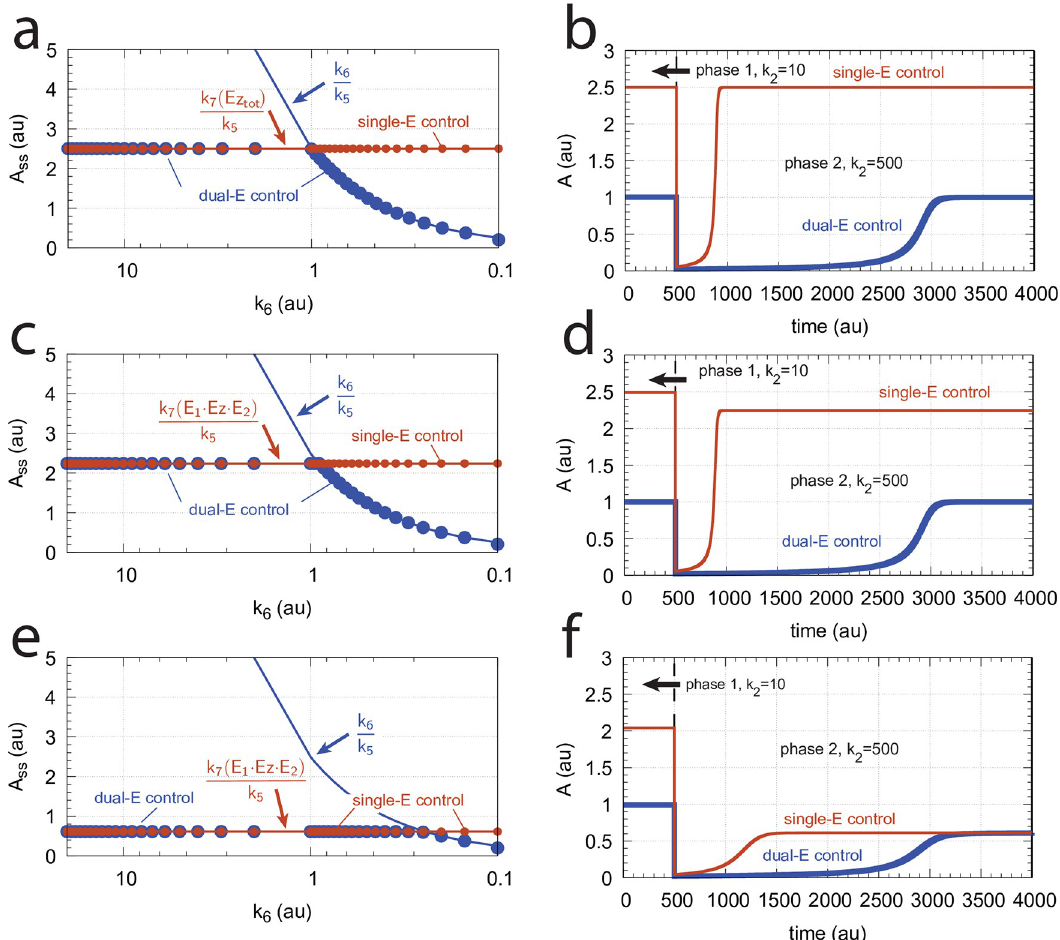
Fig 10. Behaviors of single-E control and dual-E control for the schemes in Fig 9e and 9f when going from zero-order to nonzero-order conditions. In panels (a) and (b), k 9 = k 11 = k 13 = k 15 =1 × 10 8 (zero-order condition); in panels (c) and (d), k 9 = k 11 = k 13 = k 15 =1 × 10 6 (weak nonzero-order); in panels (e) and (f), k 9 = k 11 = k 13 = k 15 =1 × 10 4 (strong nonzero-order). Panels b, d, and f to the right show the time-dependent kinetics of A for a step-wise perturbation in k 2 from 10 (phase 1) to 500 (phase 2) applied at t = 500. The k 6 values in these calculations were 0.4. Other rate constants as in Fig 9. Initial concentrations for panels (a), (c), and (e), dual- E controller: A 0 =2.0, E 1,0 =4.5 × 10 2 , E 2,0 =2.0 × 10 − 1 , Ez 0 =4.4 × 10 − 10 , (E 1 � Ez) 0 =9.7 × 10 − 7 , (E 1 � Ez � E 2 ) 0 =2.0 × 10 − 8 , (Ez � E 2 ) 0 =2.0 × 10 − 13 ; single- E controller: A 0 =2.5, E 0 =3.6 × 10 2 , Ez 0 =2.8 × 10 − 11 , (E � Ez) 0 =1.0 × 10 − 8 ; steady state concentrations were obtained after 2000 time units. Initial concentrations panels (b) and (d): dual- E controller: A 0 =1.0, E 1,0 =9.1 × 10 2 , E 2,0 =6.7 × 10 − 1 , Ez 0 =4.4 × 10 − 10 , (E 1 � Ez) 0 =6.0 × 10 − 7 , (E 1 � Ez � E 2 ) 0 =4.0 × 10 − 7 , (Ez � E 2 ) 0 =7.6 × 10 − 13 ; single- E controller: A 0 =2.5, E 0 =3.6 × 10 2 , Ez 0 =2.7 × 10 − 9 , (E � Ez) 0 =1.0 × 10 − 8 . Initial concentrations panels panel (f): dual- E controller: A 0 =1.0, E 1,0 =9.1 × 10 2 , E 2,0 =6.7 × 10 − 1 , Ez 0 =4.4 × 10 − 10 , (E 1 � Ez) 0 =6.0 × 10 − 7 , (E 1 � Ez � E 2 ) 0 =4.0 × 10 − 7 , (Ez � E 2 ) 0 =7.6 × 10 − 13 ; single- E controller: A 0 =2.04, E 0 =4.5 × 10 2 , Ez 0 =1.8 × 10 − 7 , (E � Ez) 0 =8.1 × 10 − 7 . Fig 10 illustrates the behavior going from zero-order to nonzero-order conditions. To impose nonzero-order conditions we have for the sake of simplicity, changed the values of k k 11 , k 13 , and k 15 from 1 × 10 8 (practical zero-order, panels a and b) to 1 × 10 6 (panels c and d) and 1 × 10 4 (panels e and f), while other rate constants are kept unchanged. In all panels sin- gle- E control responses are outlined in red, while dual- E control is outlined in blue. Fig 10 clearly shows that when the system moves into a nonzero-order kinetics regime (by lowering k 9 , k 11 , k 13 , and k 15 ) the performance by single- E control gets successively worse. However, although dual- E control can maintain/defend its set-point (Eq 14) the range of the dual- E